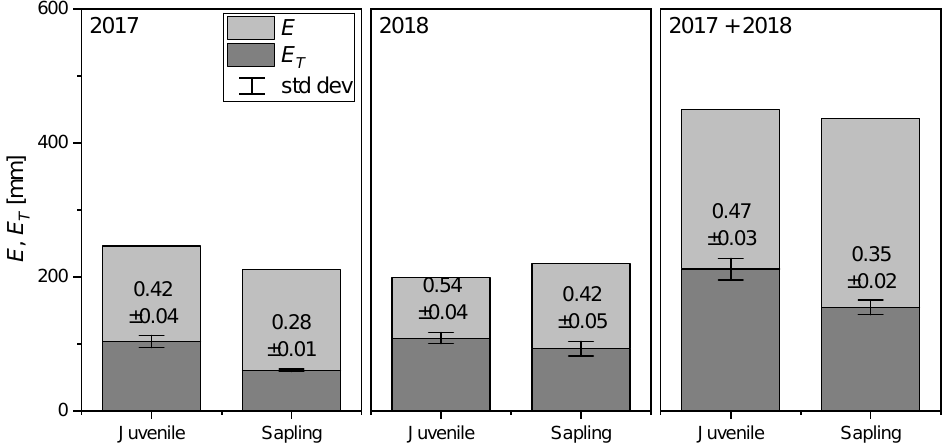
Figure 9. Summary of evapotranspiration ( E ) and transpiration ( E T ) from 5 July to 18 October in 2017 and 2018. The numbers above E and E T bars are mean E T / E values ± standard